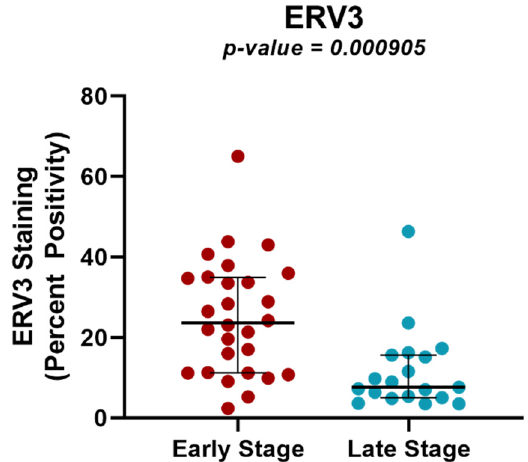
Figure 4. Differential ERV3 expression by immunohistochemistry (IHC) between early- and locally advanced-stage cervical cancers. Scatter plot representing the IHC results of a tissue microarray of cervical cancer samples stained with ERV3 antibodies. ERV3 expression is significantly different between the early-stage (n = 28) and late-stage (n = 19) cohorts ( p = 0.000905). The y-axis represents the percentage of tumor cells that are positive for ERV3. Early = FIGO early stage IA1–1B2; Late = FIGO locally advanced stage IB3-IVA.